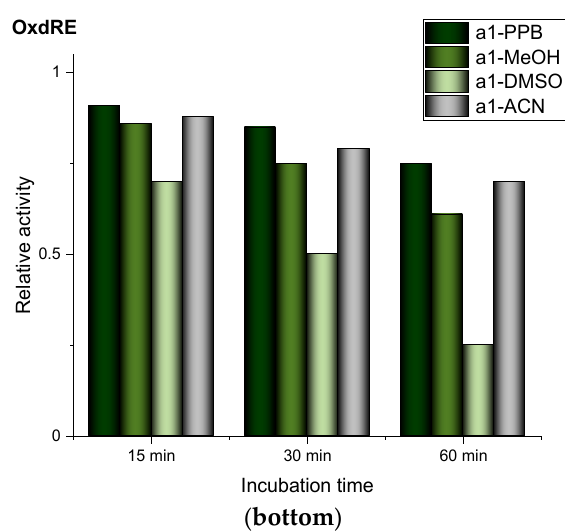
Figure 4. Cosolvent study of immobilized OxdB ( top ) and OxdRE ( bottom ).